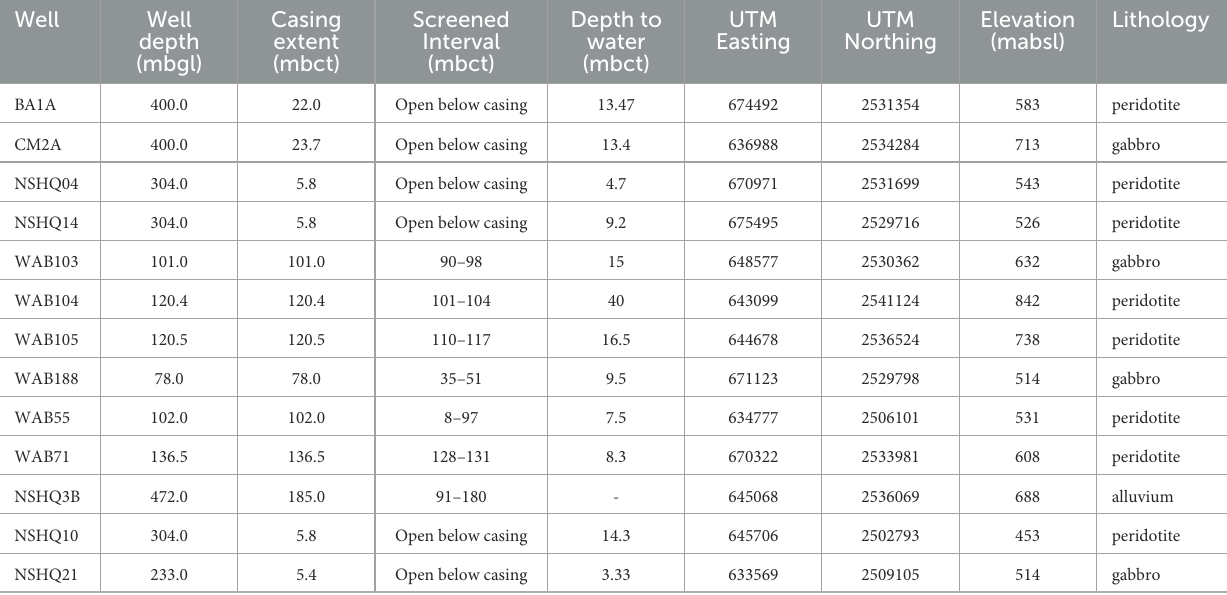
TABLE 1 Lithology, geographic location, elevation, depth, and borehole properties of wells sampled as previously reported by Rempfert et al. (2017) and Nothaft et al.